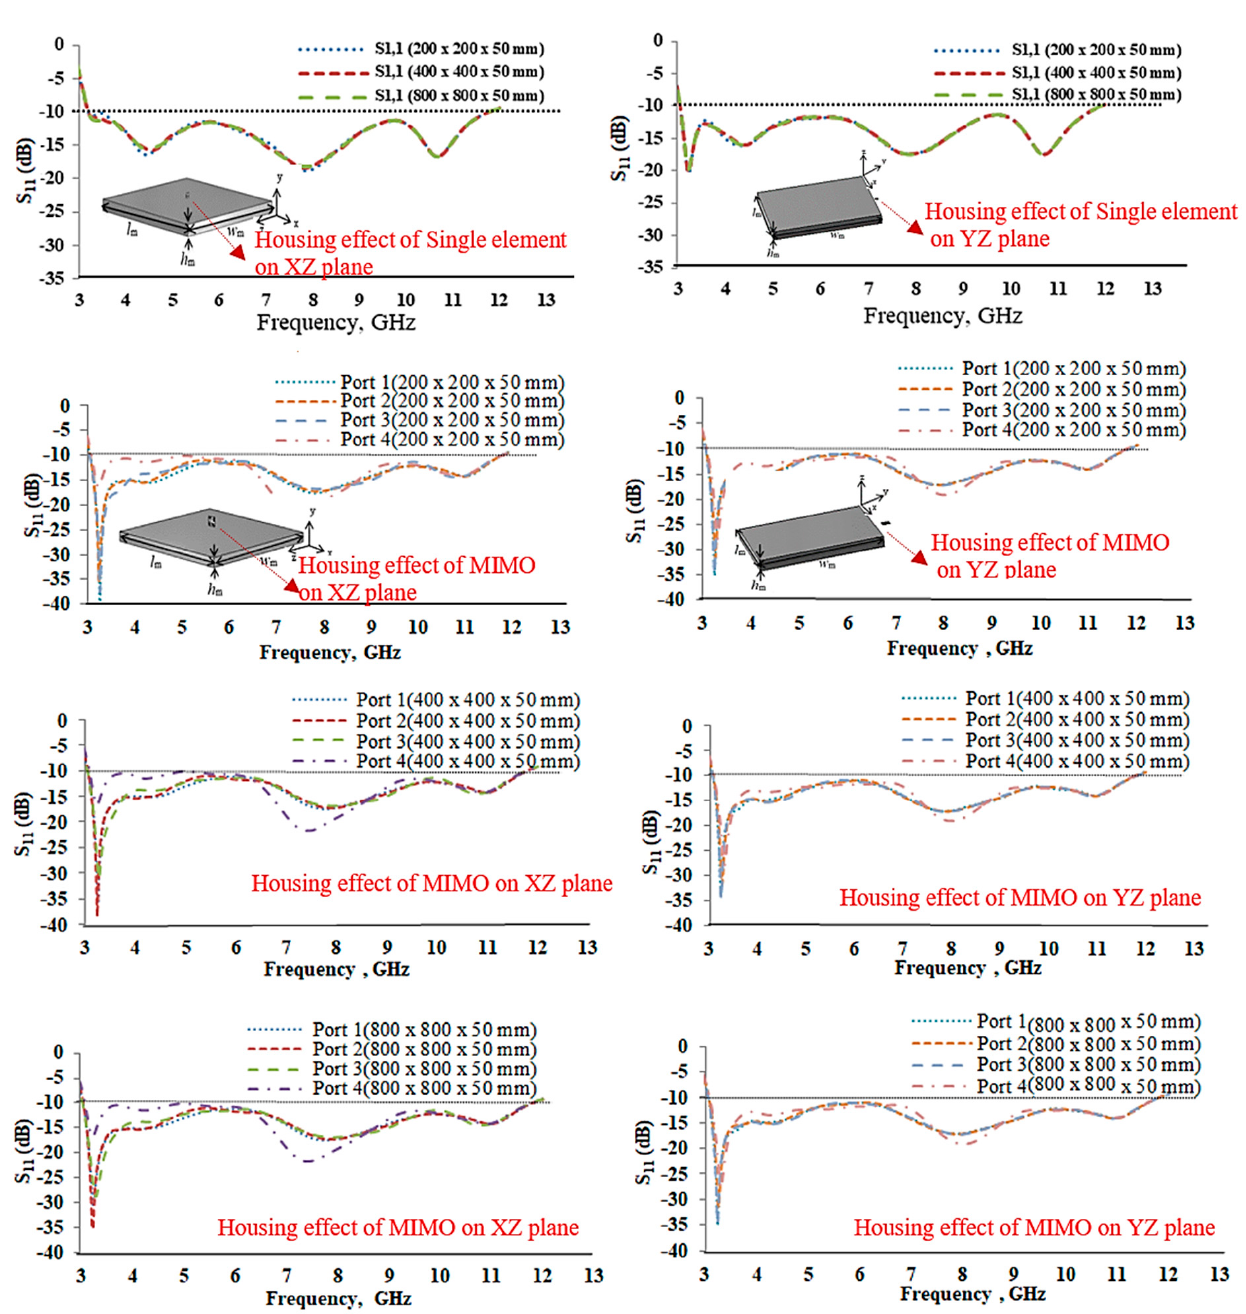
Figure 11. The unit antenna element/MIMO antenna bandwidth performance when the housing effect is taken into account.